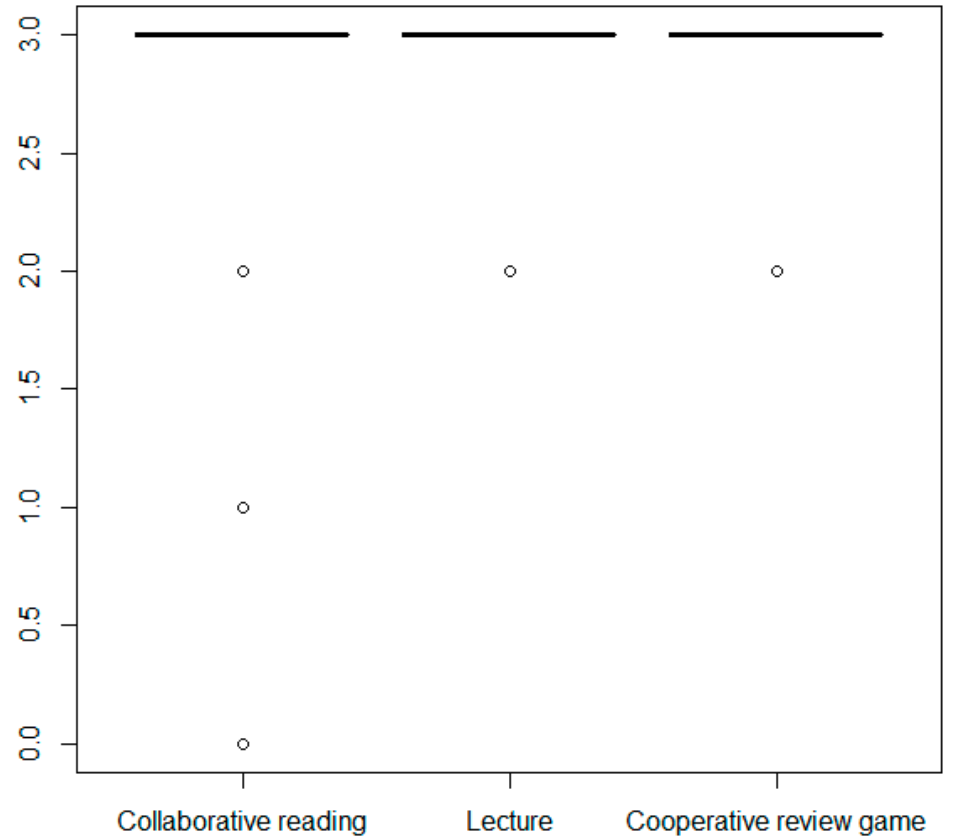
Figure 4. Responses to the question “Socrative made the task more enjoyable than (i) traditional reading tasks (ii) a lesson consisting only of theoretical explanations (iii) traditional review tasks/lessons”.